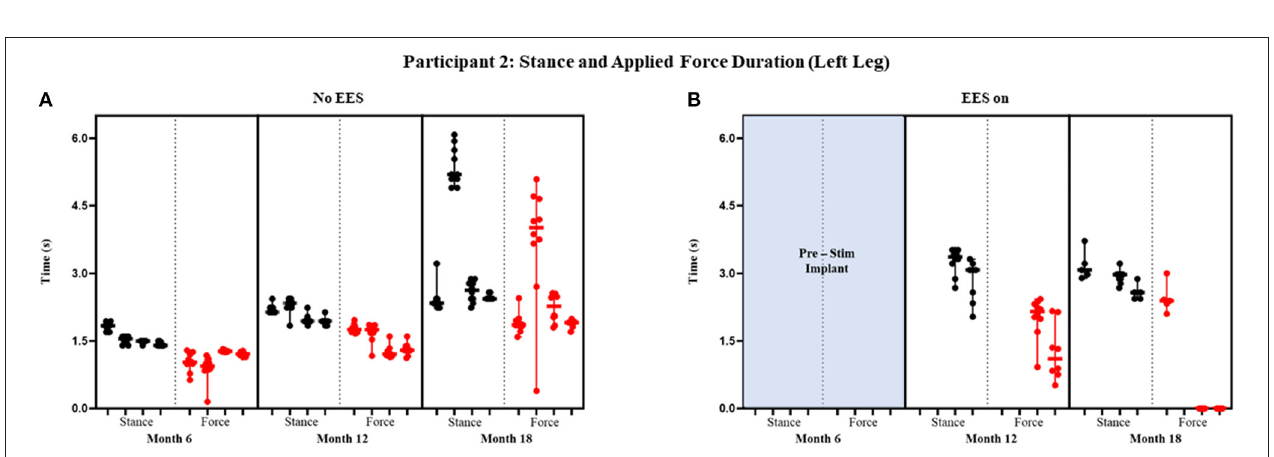
FIGURE 6 | Participant 2: maximum applied force during stance. Maximum applied force during stance phase of the gait cycle with line at the median and range for left leg (A) and right leg (B) . Each tick in the x-axis represents a trial of up to 10 consecutive stance cycles. The dots represent the maximum force for each consecutive cycle where black, red, and blue dots correspond to month 6, 12, and 18, respectively.